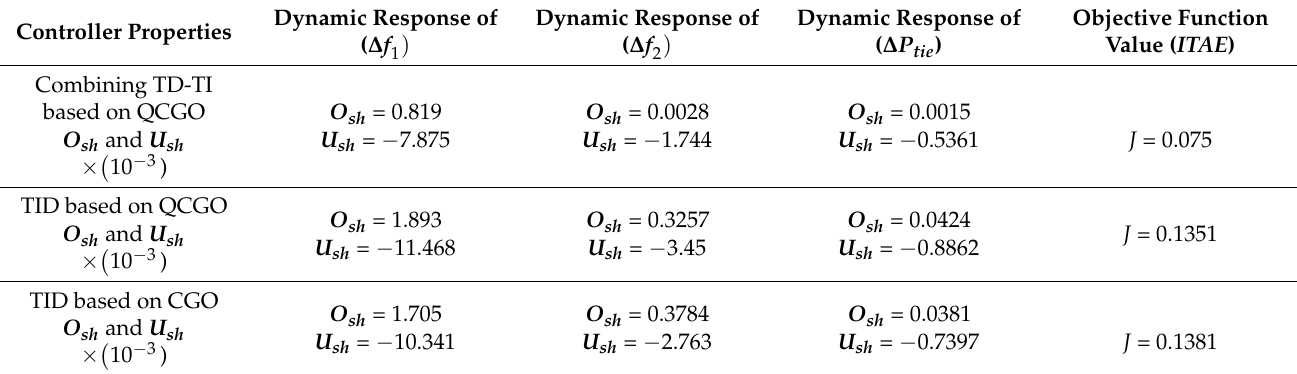
Table 10. The transient response specifications of the presented system for case A.1.2.